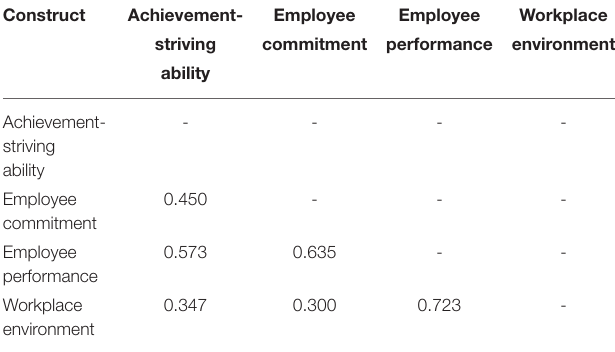
TABLE 4 | Discriminant validity (HTMT).